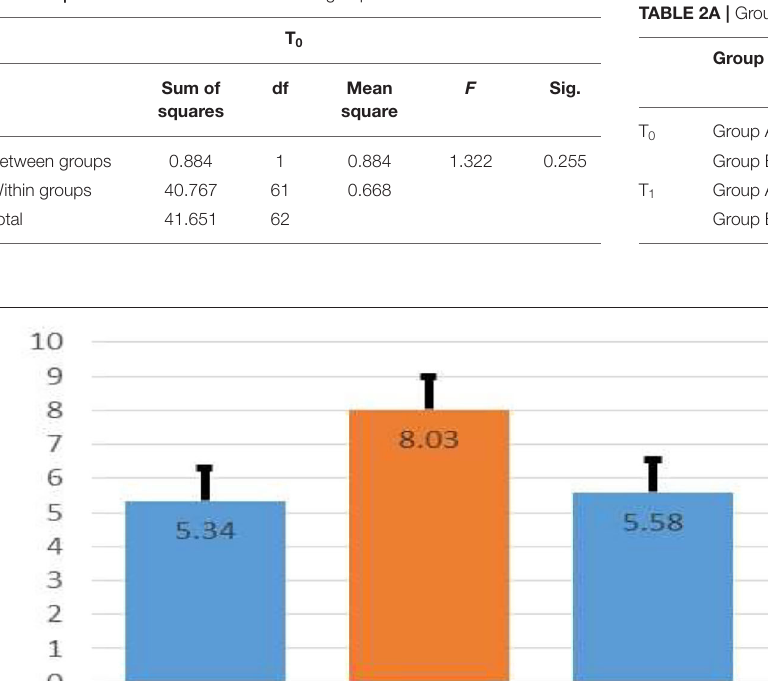
TABLE 1 | Initial emotional conditions of two groups.